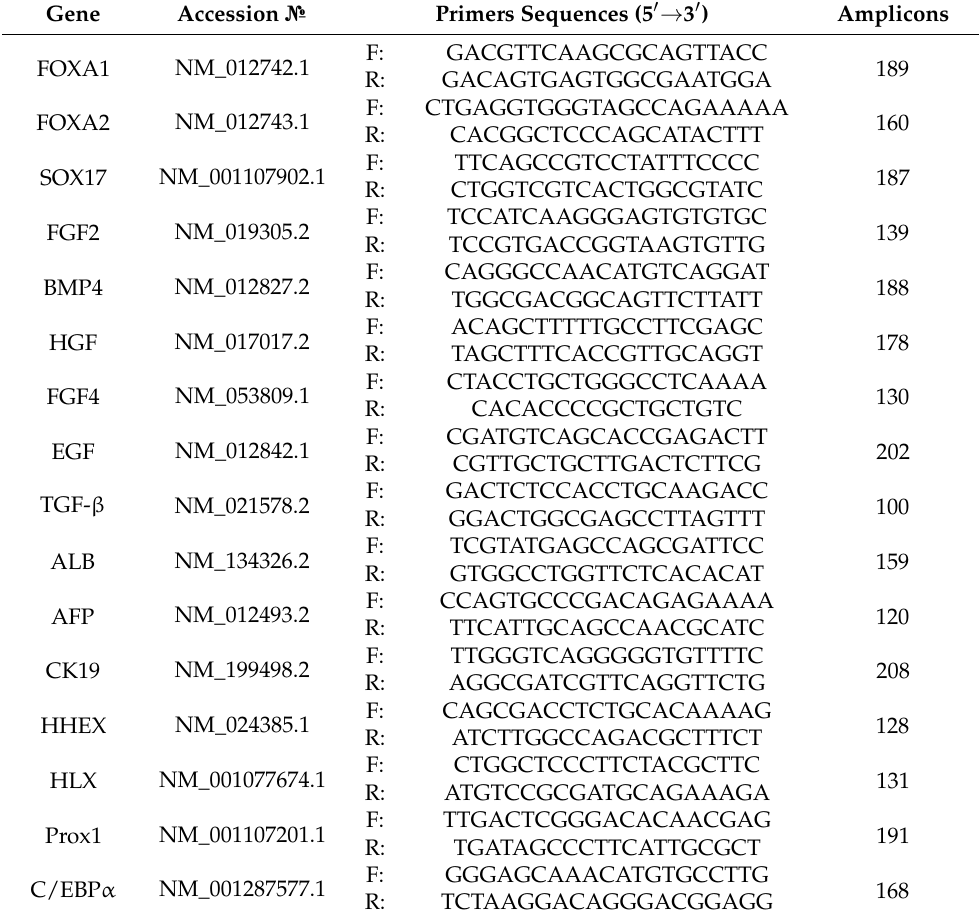
Table 1. Sequence of primers used in RT-PCR. Gene Accession